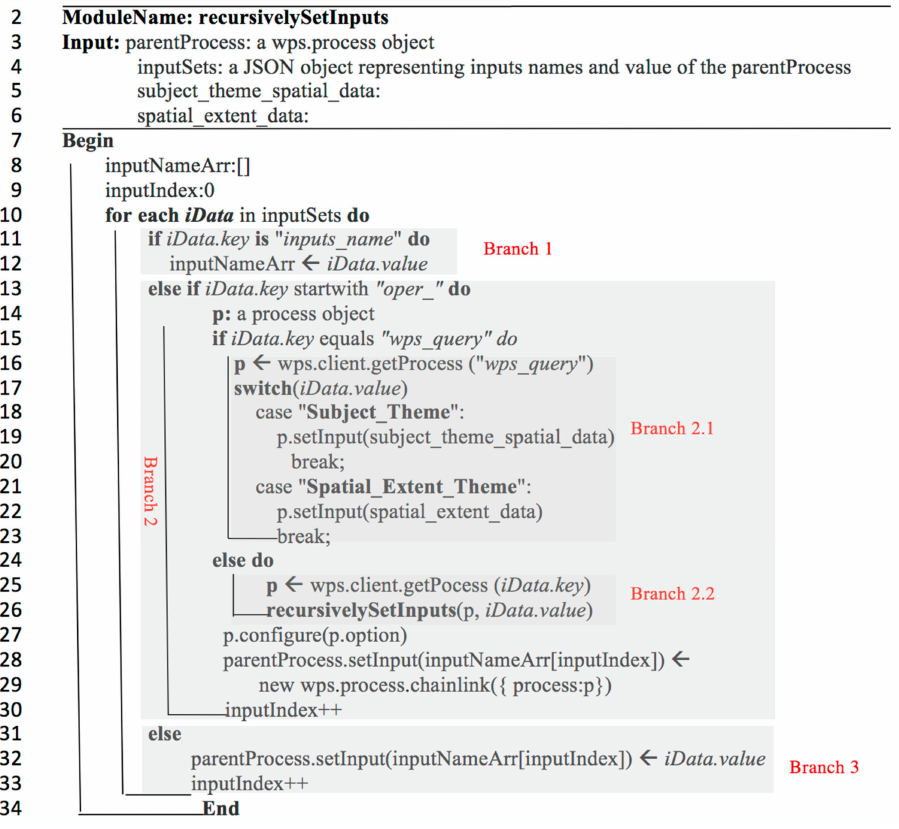
Figure 7. Algorithm for recursively setting the input of a